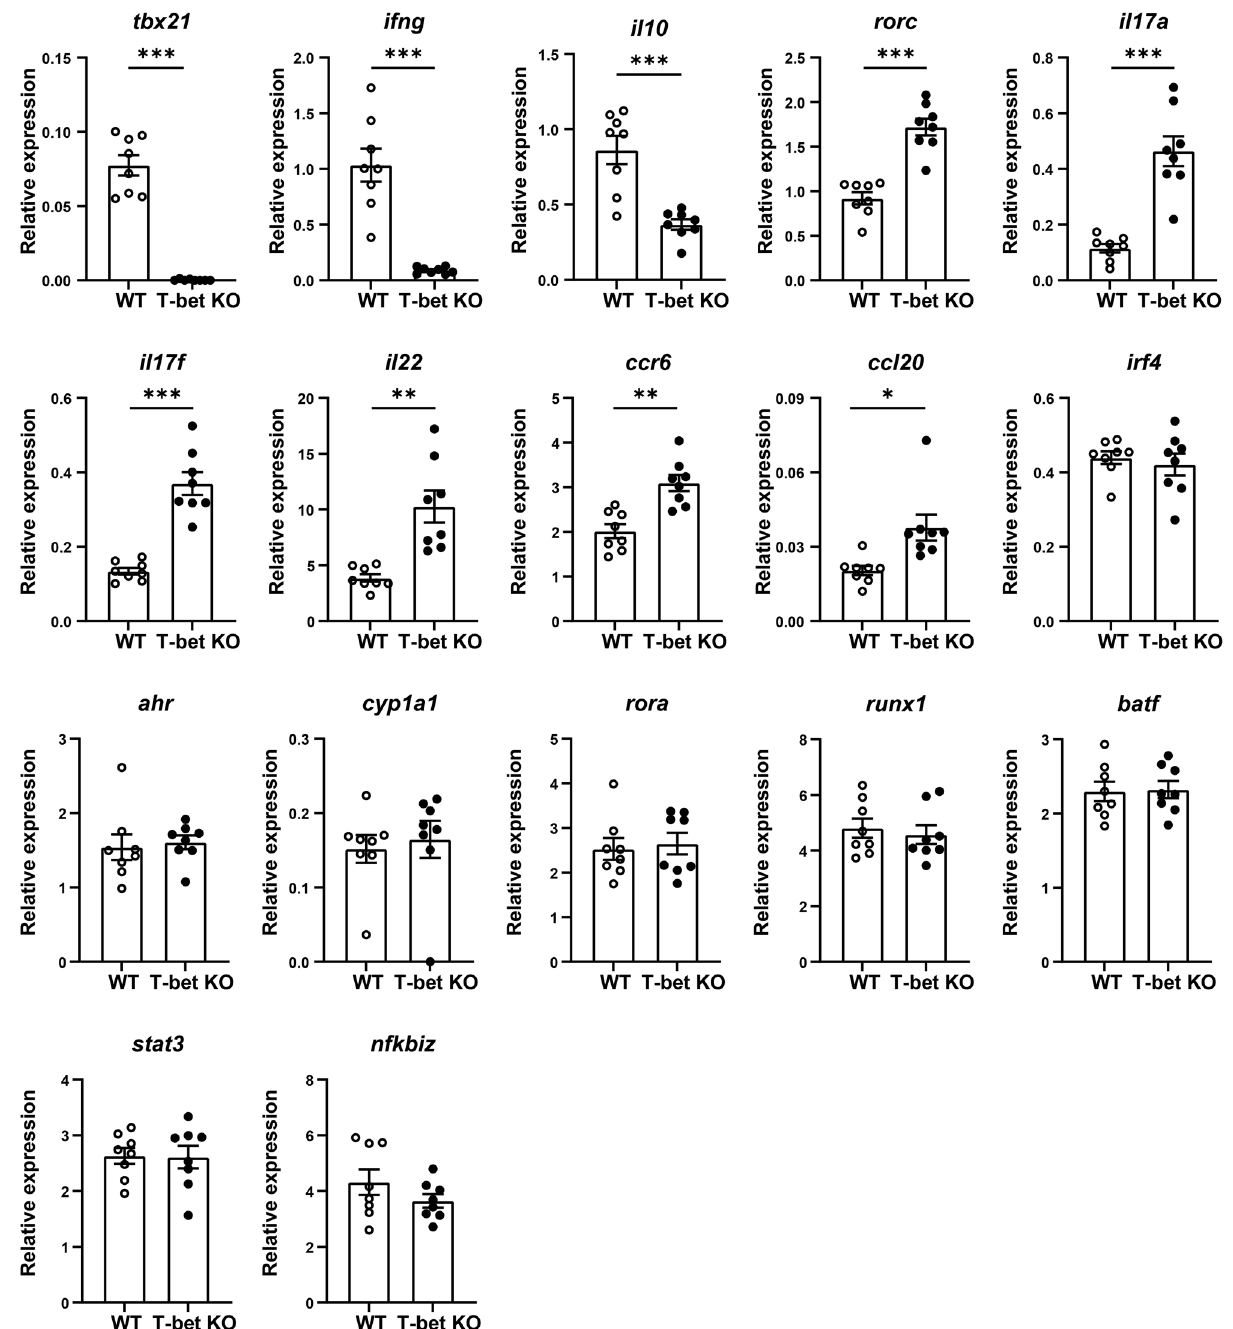
Figure 3. T-bet suppressed expression of rorc and its target genes including il17a , il17f , and il22 in CD4 + T cells. At day 10 post first immunization with CII, CD4 + T cells were isolated from the draining LNs of WT mice (n = 8) and T-bet KO mice (n = 8). The expression levels of the genes were analyzed using qRT-PCR. Data are presented as mean ± SEM. Statistical tests: Welch’s t test. (** P < 0.01, *** P < sion of RORγt in vitro, which is consistent with the results of the previous ex vivo experiment which revealed that T-bet inhibited IL-17A production from RORγt + CD4 + T cells after CII immunization. CIA was exacerbated in CD4‑Cre T‑bet fl/fl mice with a higher percentage of Th17 cells infiltrat - ing into the arthritic joints. To evaluate the role of T-bet in CD4 + T cells on the pathogenesis of arthritis, we generated T-bet conditional KO (cKO) mice by crossing CD4-Cre mice with T-bet fl/fl mice (which selectively lose the T-bet gene in T cells) (Fig. S4), and compared the severity of CIA in T-bet fl/fl control mice and cKO mice. The severity of arthritis induced in cKO mice was significantly more severe and its incidence was also signifi-